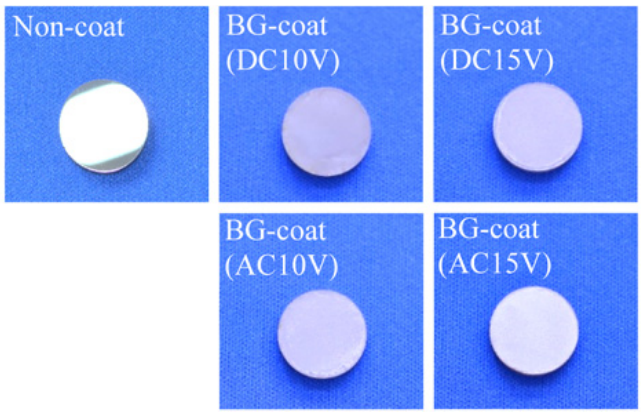
Figure 1. Photomicrographs of the non ‐ and bioactive glass (BG) ‐ coated specimens.